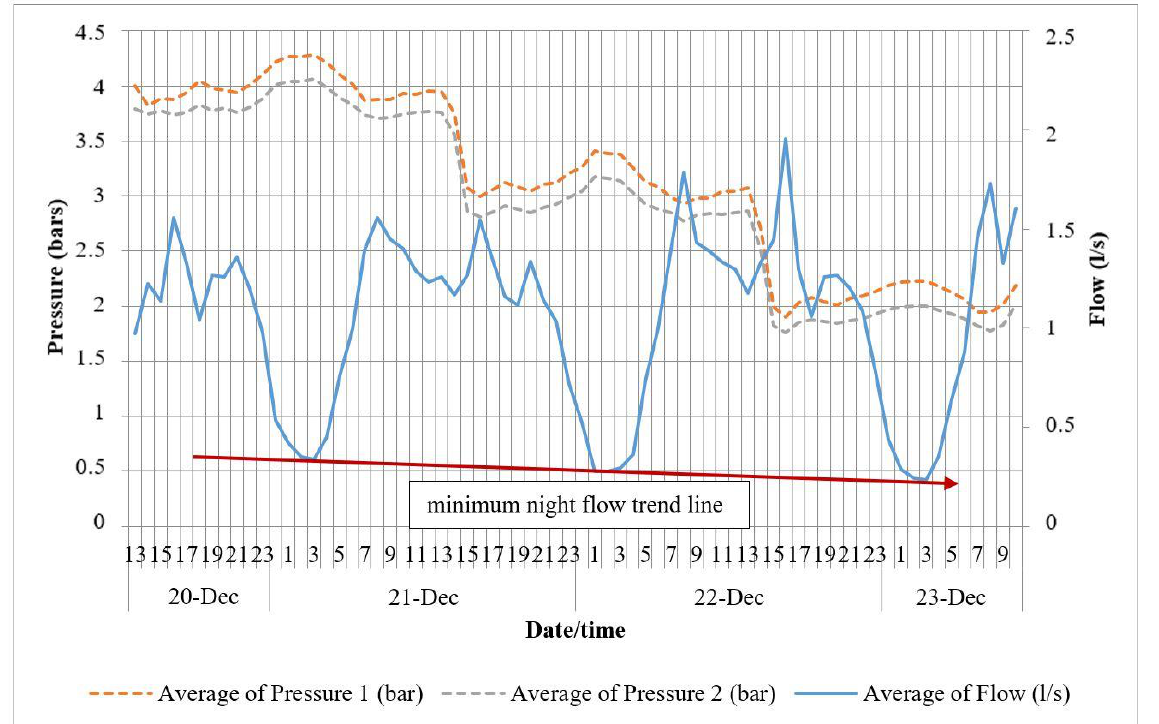
Figure 4. Measured pressure on two locations and measured flow with MNF trend